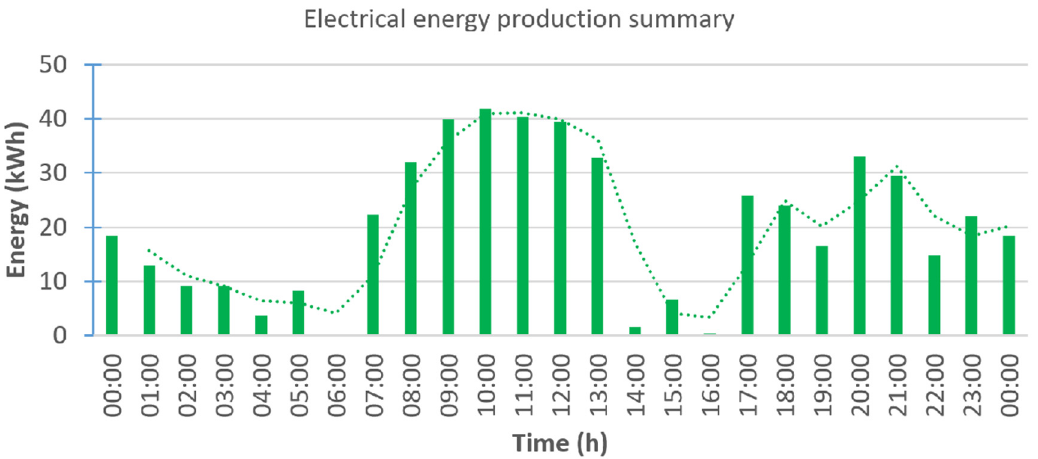
Figure 9. Electrical energy production summary profile during a 24 h cycle. Own study based on source [55].